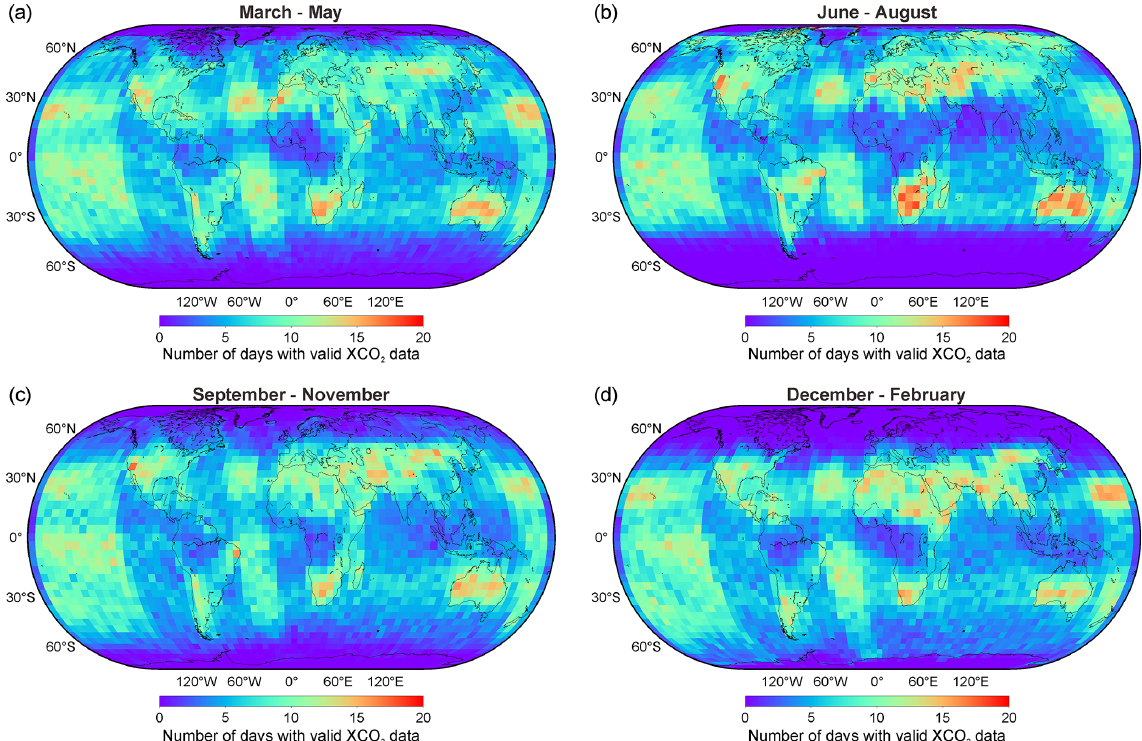
Figure 2. Spatial and seasonal distributions of the valid OCO-2 XCO 2 retrievals between 2015 and 2020. The numbers of days with valid OCO-2 XCO 2 retrievals (xco2_quality_flag = 0) in each GEOS-Chem 4 ◦ × 5 ◦ grid cell are shown for the periods spanning (a)